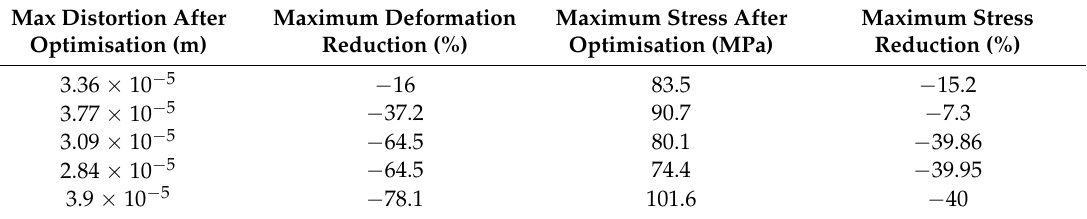
Table 5. Analysis results of optimised rear end cover suspension strength.